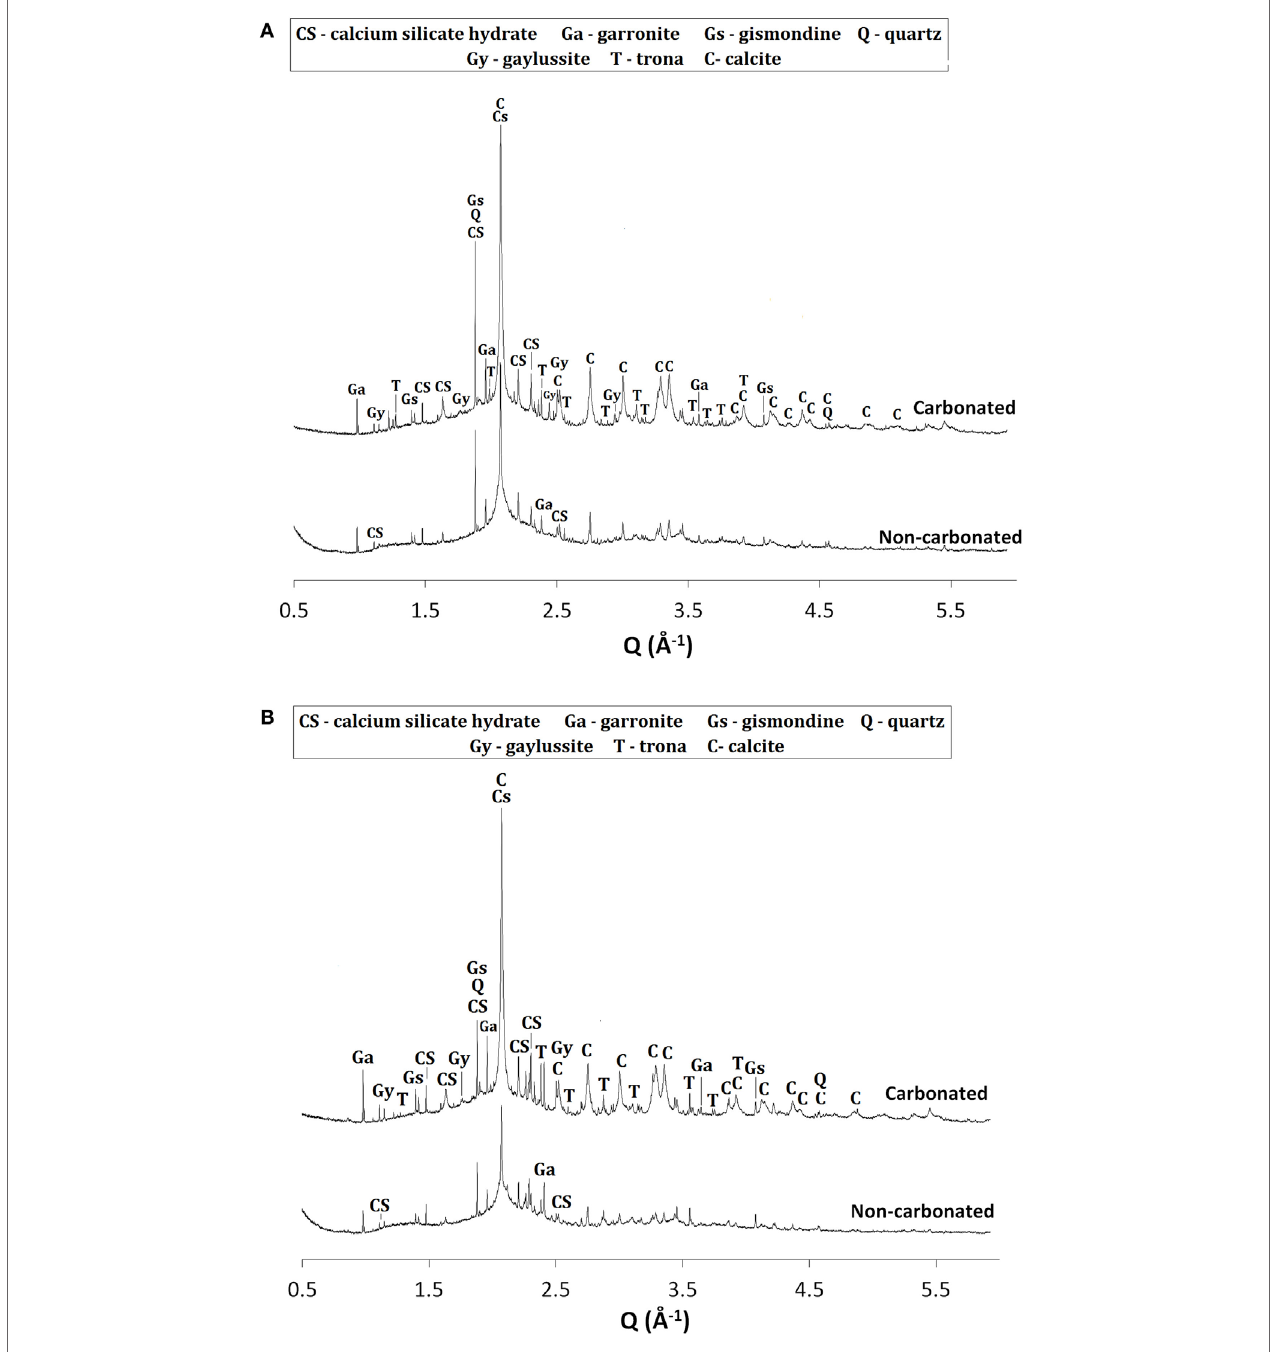
FigUre 1 | high-resolution synchrotron X-ray diffraction patterns of non-carbonated from bernal et al. (2013b) and accelerated-carbonated alkali-activated pasted with a gbFs/(gbFs + MK) of (a) 1.0, (b) 0.9, and (c) 0.8